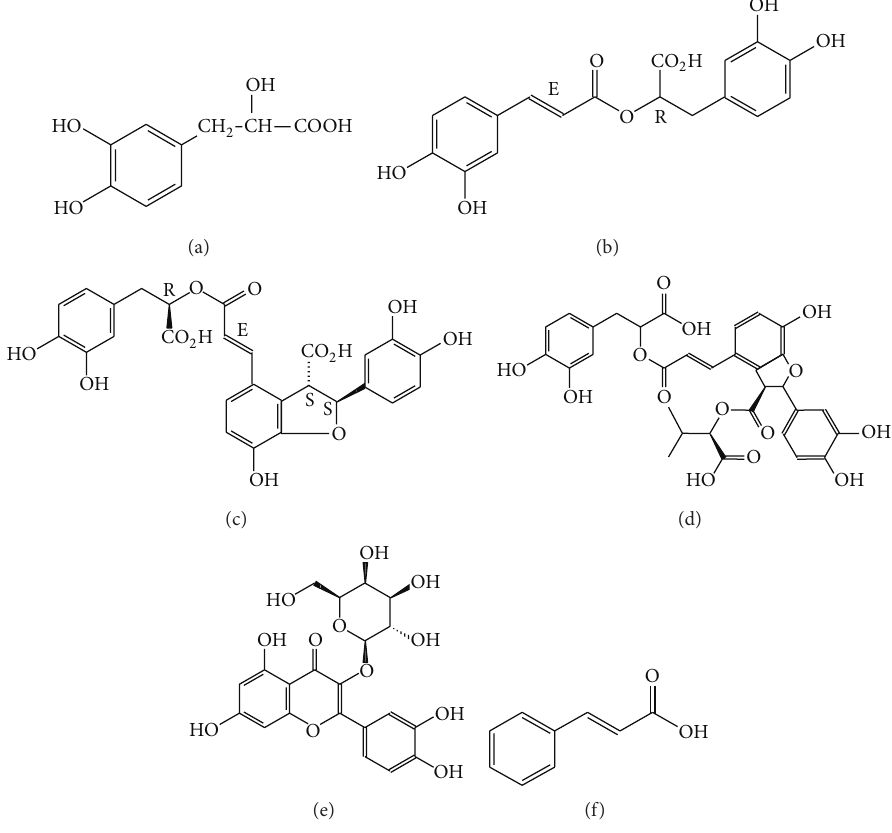
Figure 1: Chemical structures of DSS (a), RA (b), LA (c), SAB (d), HP (e), and CA